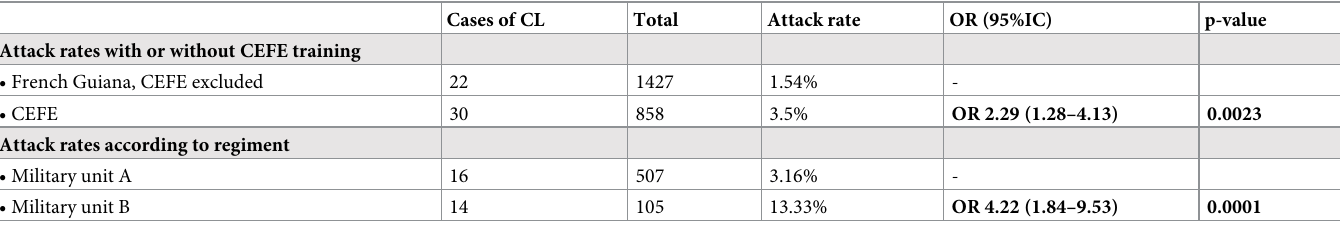
Table 3. Comparison of attack rates of CL in French Guiana during the study period, according to attendance of a CEFE course and regiment, 2020. Cases of